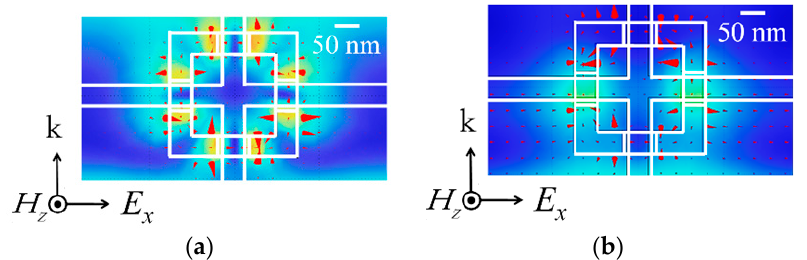
Figure 9. Simulated magnetic field distribution around an individual tri-gate metamaterial (TGM) having appropriate dimensions at ( a ) 190 THz and ( b ) 230 THz. The distribution of vector field is also visualized by a red arrow.